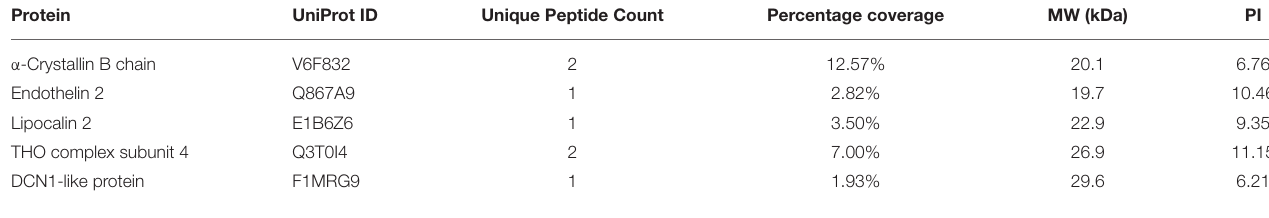
TABLE 3 | MbovP280-binding ligands in BoMac screened with IP-MS. Protein UniProt ID